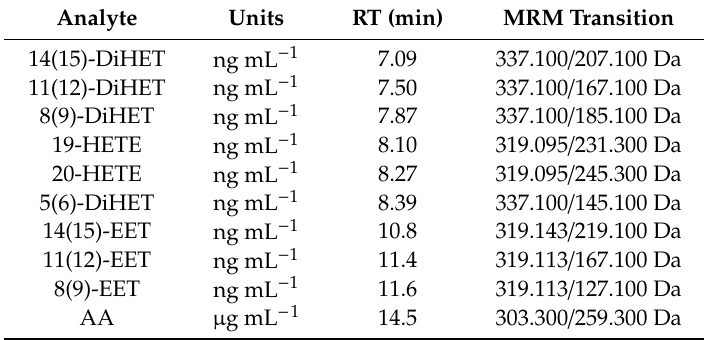
Table 5. List of standards used for liquid chromatography-tandem mass spectrometry. Analyte